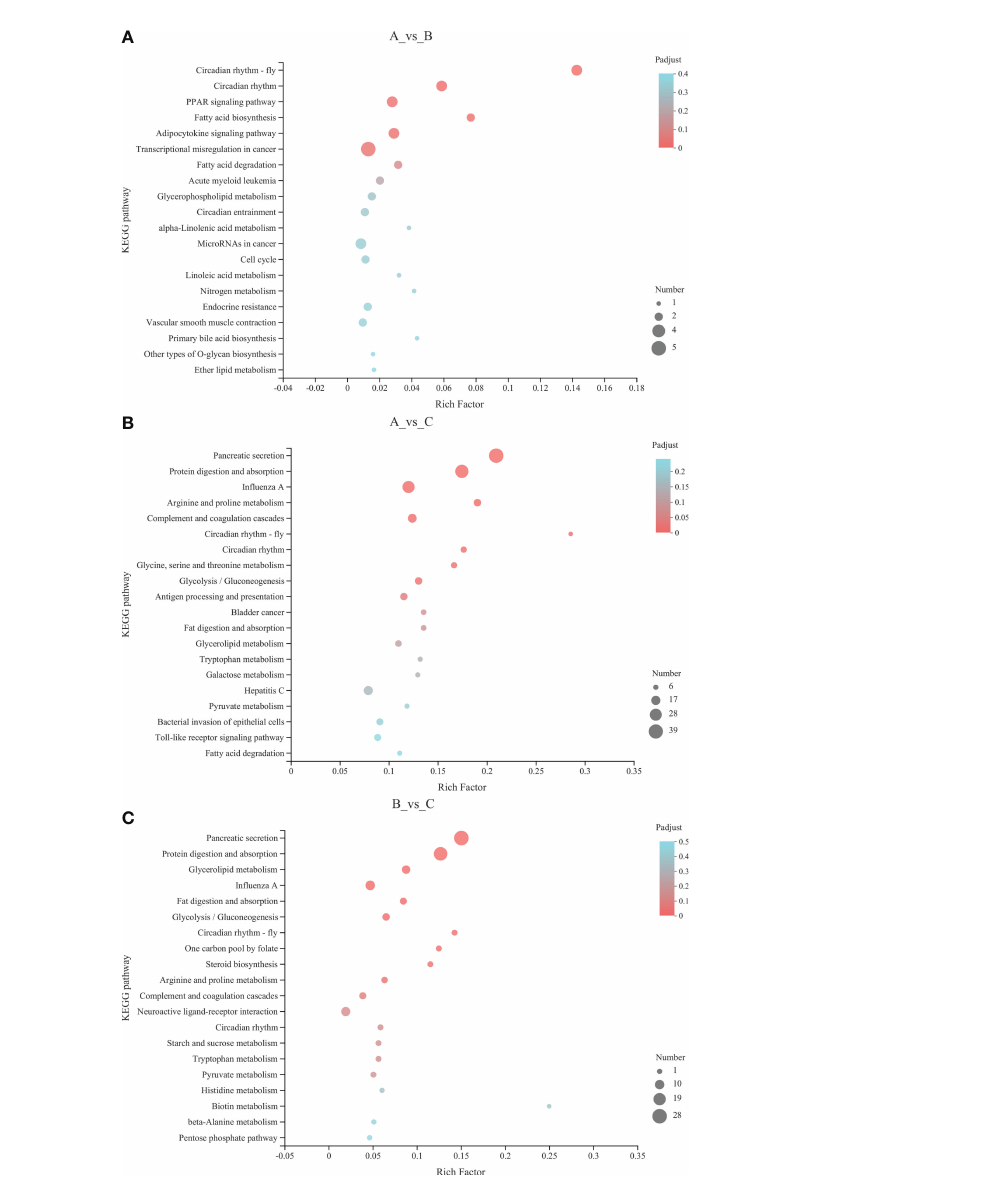
FIGURE 3 KEGG enrichment analysis bubble diagram. (A) 13°C group compared with 18°C group; (B) 8°C group compared with 18°C group; (C) 8°C group compared with 13°C group. The Y-axis represents the pathway name. The X-axis represents the number of genes. The size of the points represents the number of genes in the pathway. The colors of the points correspond to different Padjust